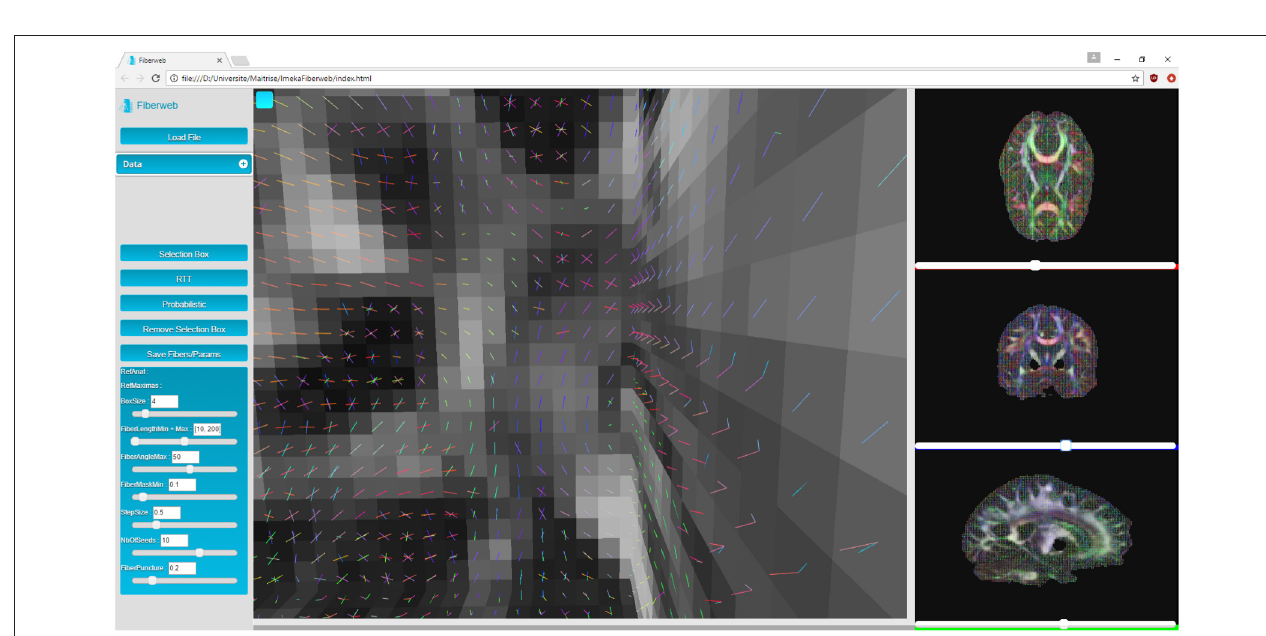
FIGURE 1 | Anatomy visualization in 3D and 2D views inside Fiberweb.